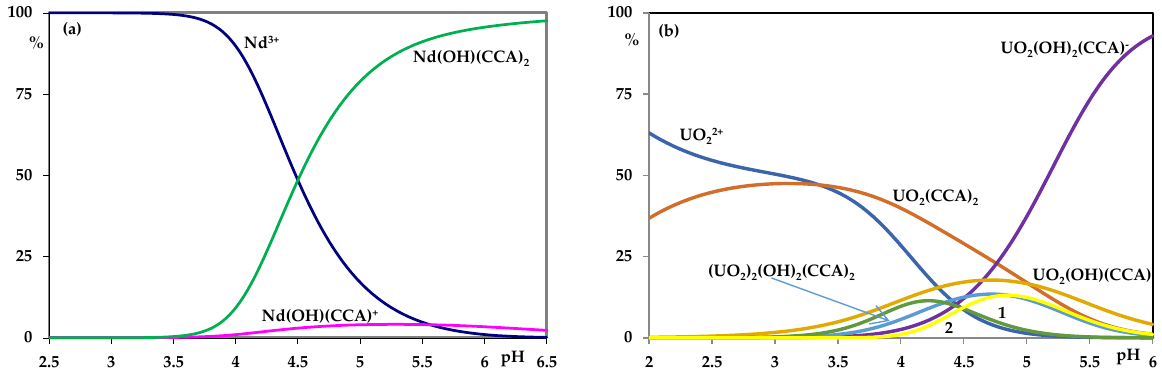
Figure 4. Distribution diagrams in the presence of HCCA of ( a ) Nd 3+ ( C M = 1.0 mM and C L = 2.0 mM) and ( b ) UO 22+ ( C M = 2.5 mM and C L = 2.5 mM). One (green line) and 2 (yellow line) in ( b ) are the hydrolytical species (UO 2 ) 2 (OH) 22+ and (UO 2 ) 3 (OH) 5+ , respectively.